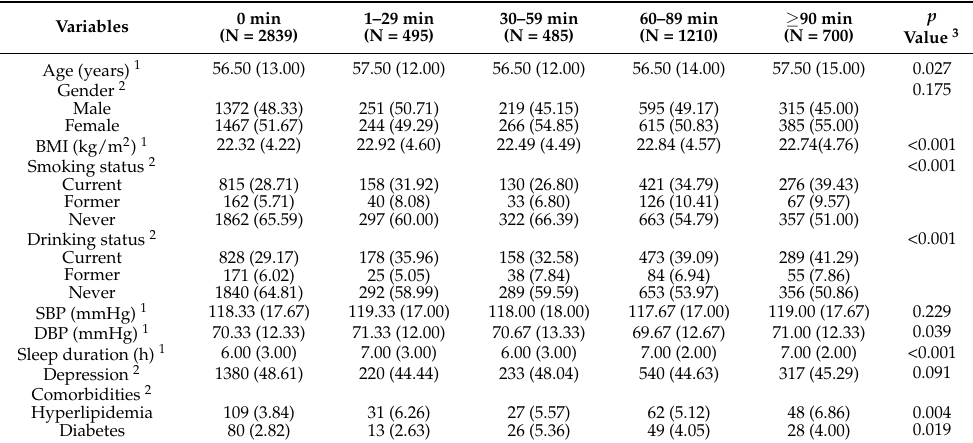
Table 1. Baseline characteristics of participants by midday nap duration groups (N =